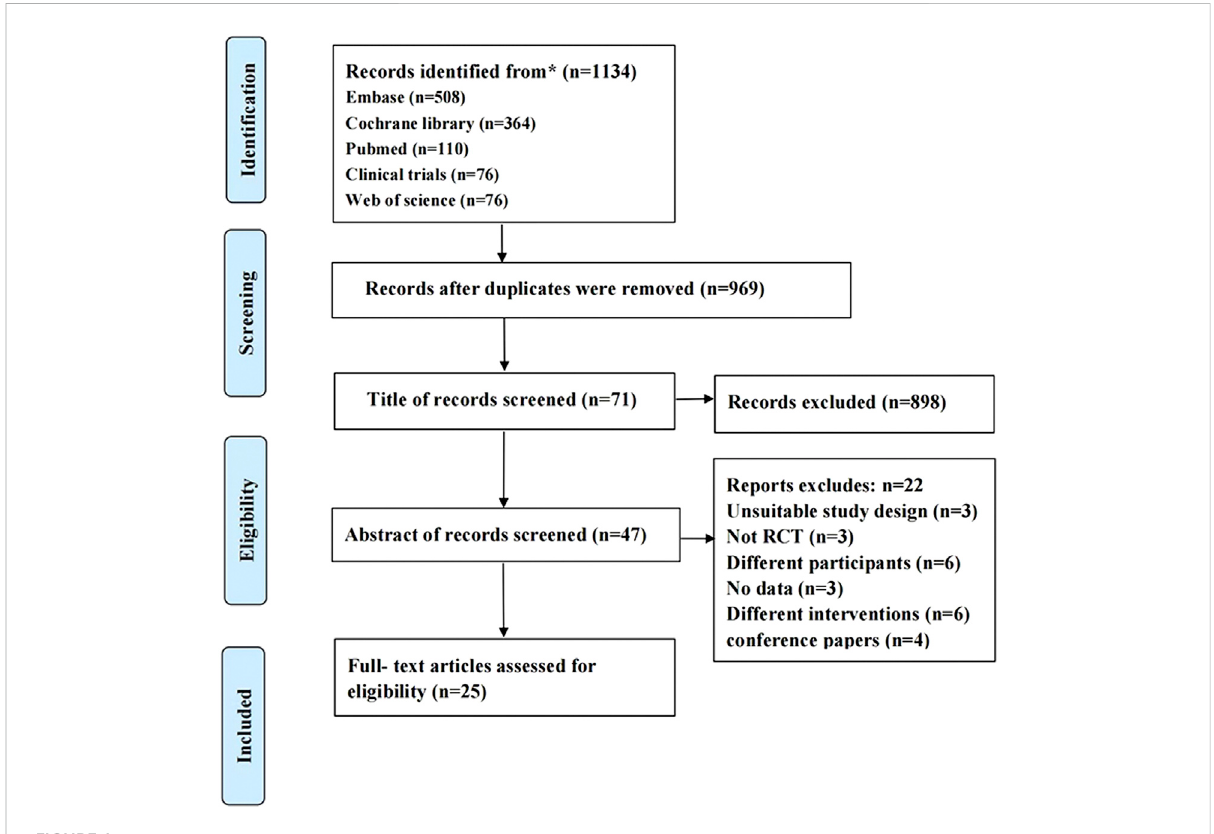
FIGURE 1 Prisivia fl ow chart of literature